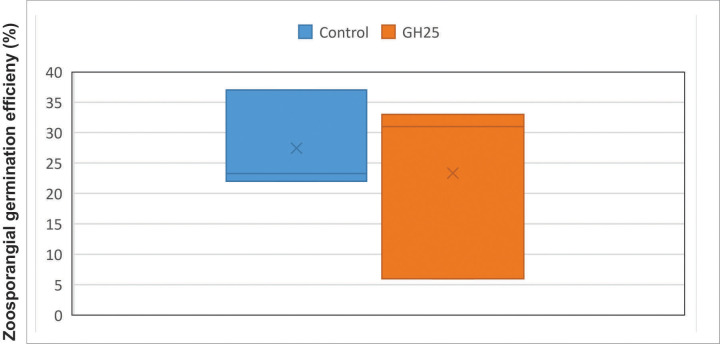
Boxplot analysis of GH 25 treatment on in vitro A. laibachii zoosporangial germination in three biological replicates analyzing about 100 zoosporangial cells for each replicate.A p-value of 0.3 was obtained for paired t-test using one-tailed distribution.